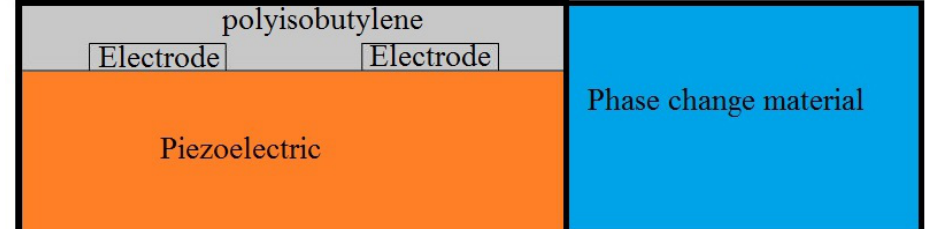
Figure 2. Geometry of the unit cell of the proposed surface acoustic wave (SAW) unit cell where cooling system is interacted with electrical